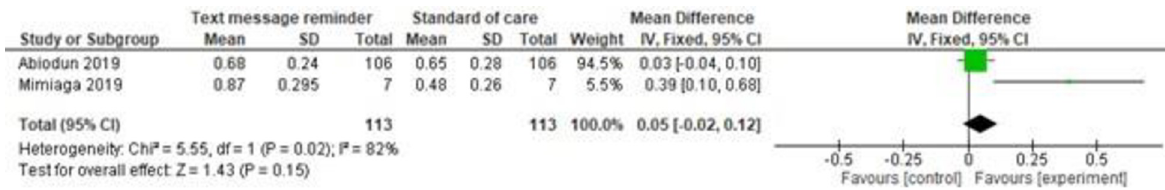
Fig 6. Forest plot of a sub-group analysis of text message versus standard of care of studies with short follow-up period.